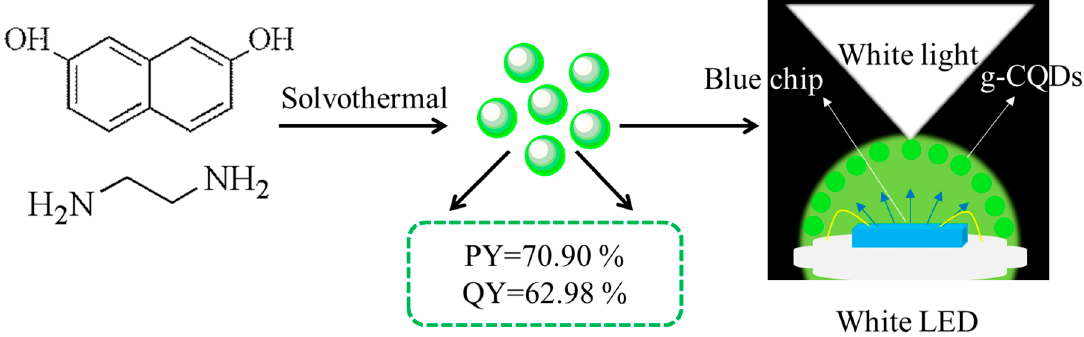
Figure 1. Schematic diagram of the synthesis of green carbon quantum dots (g-CQDs) and their application in white light emitting diodes (white).